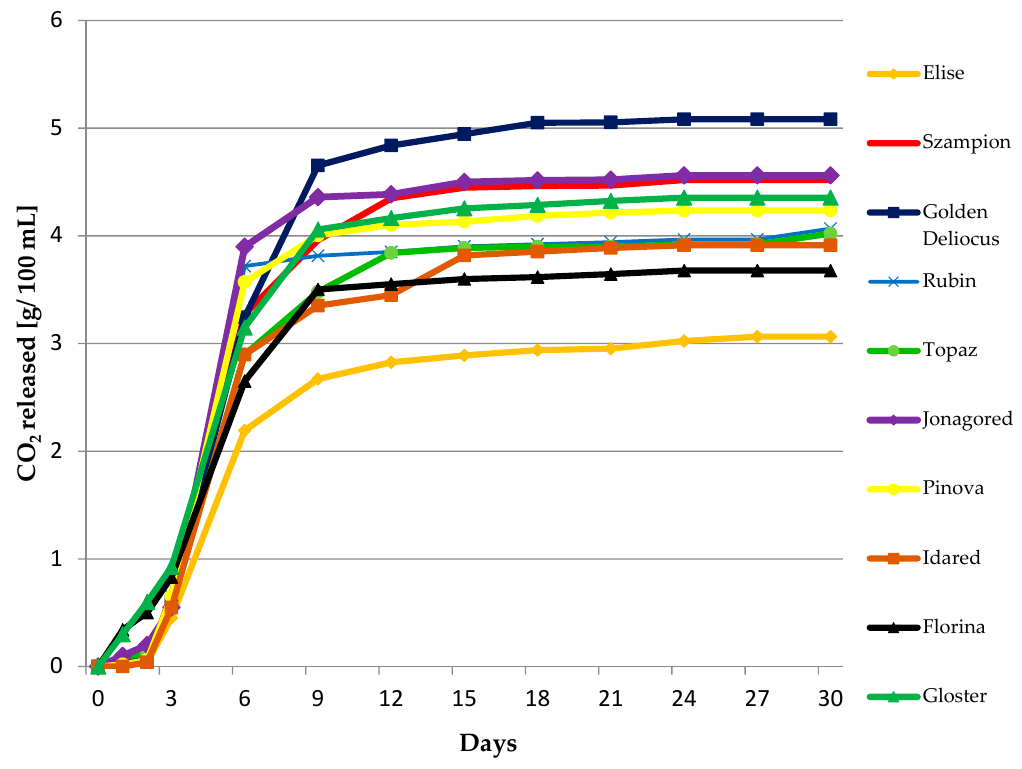
Figure 1. Fermentation dynamics of apple musts, n = 3, STD < 5%.